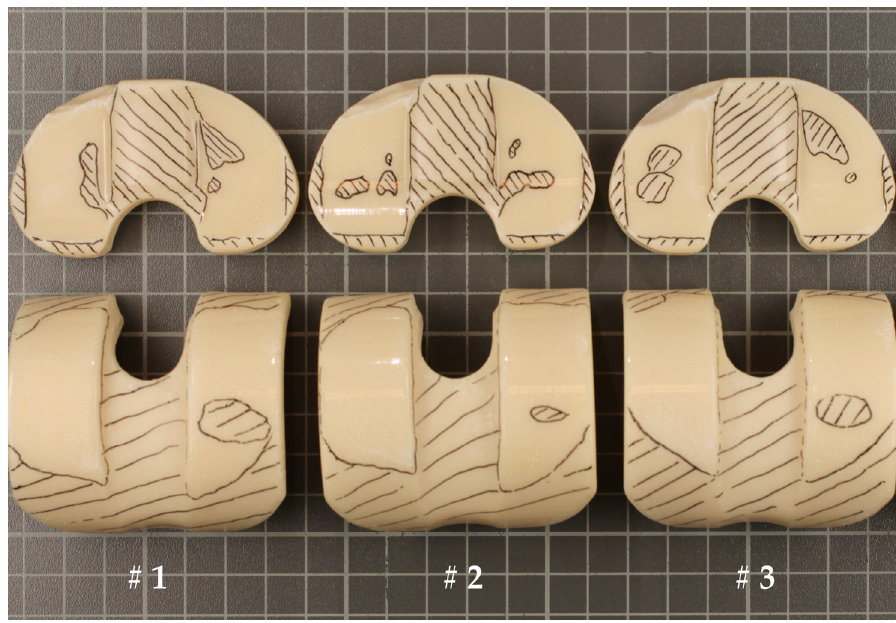
Figure 4. Worn areas on the three (#1–#3) tested BS-cement specimens.